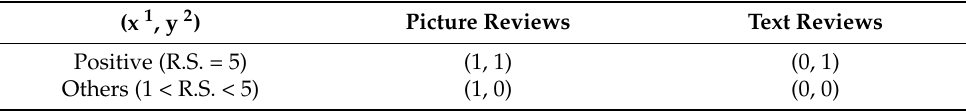
Table 9. Type of review—Review score